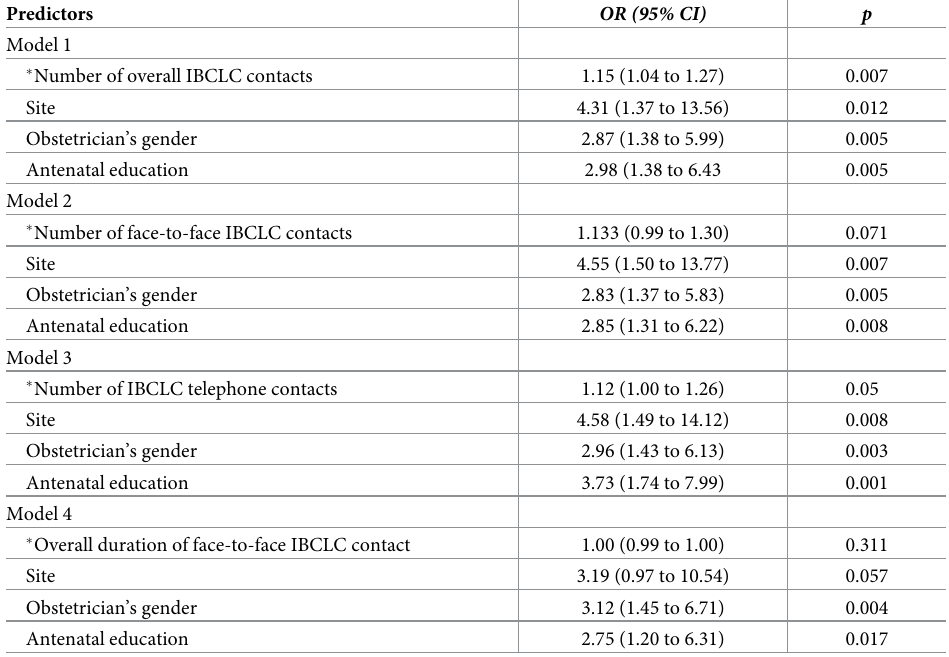
Table 4. Predictors of six-month exclusive breastfeeding ( N =